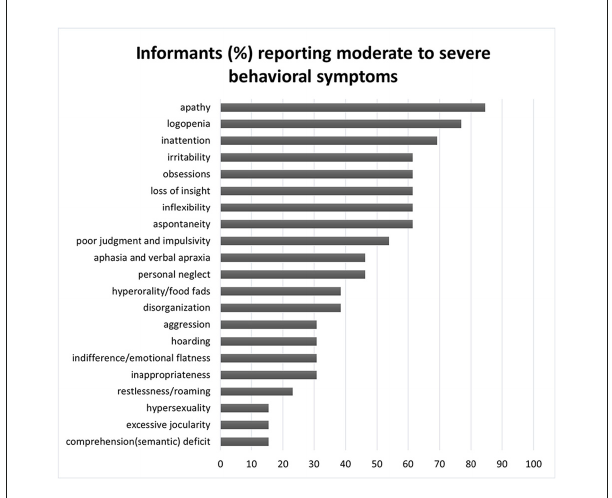
FIGURE1 Frequency of moderate-to-severe behavioral symptoms in FTD patients as reported by knowledgeable informants. FTD, frontotemporal dementia.